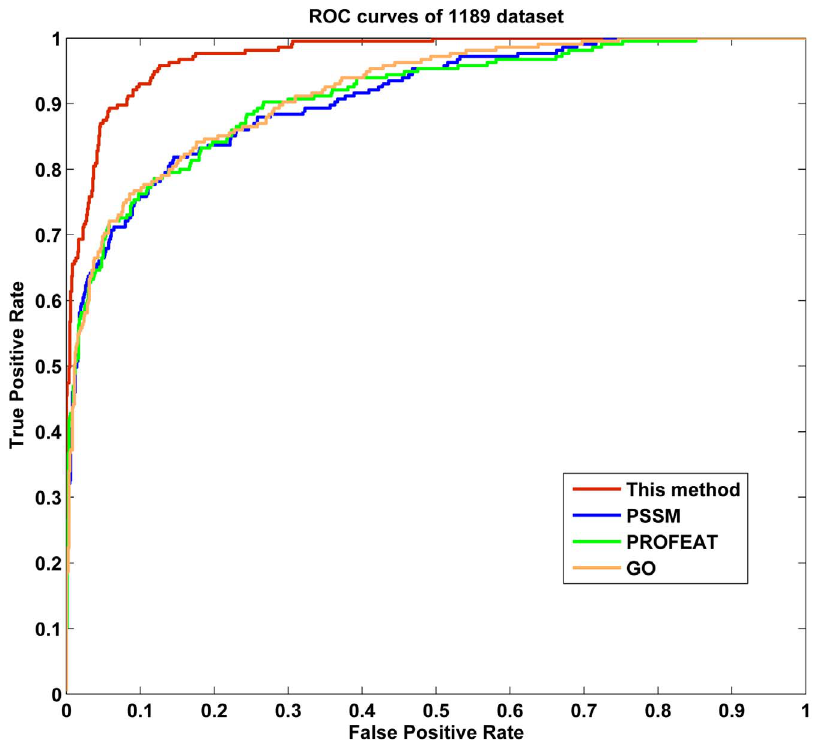
Figure 4. This graph shows the ROC curves of 1189 dataset.